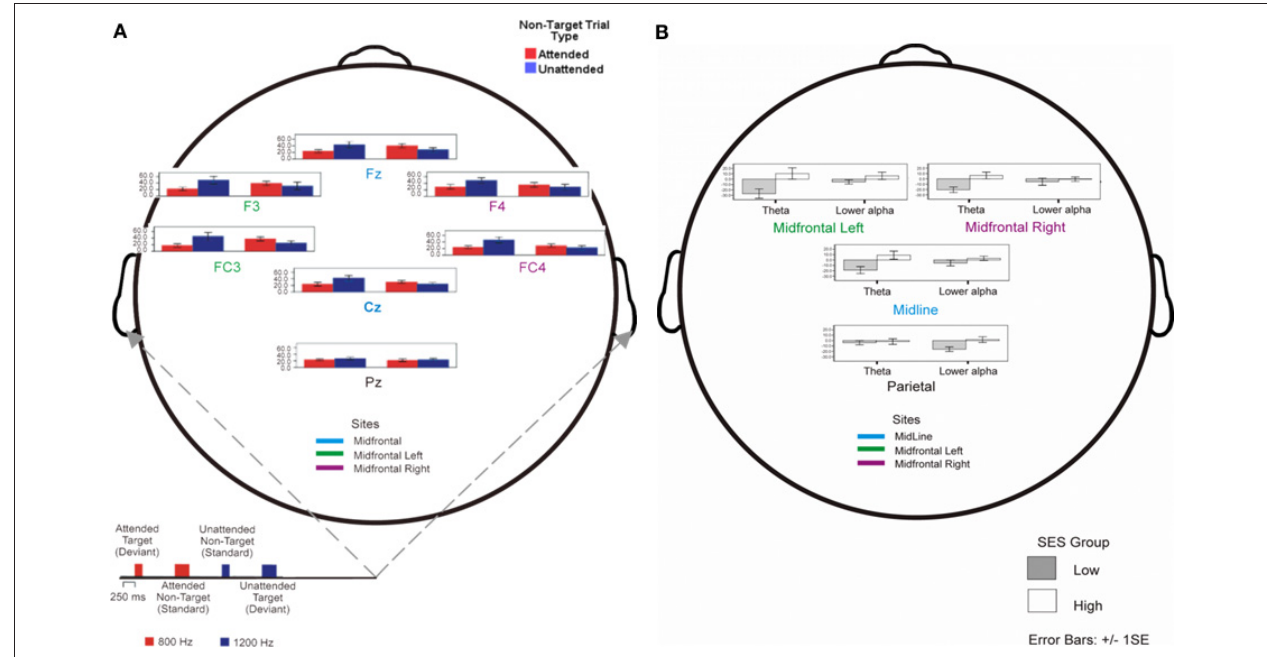
FIGURE 4 | (A) Group-mean event-related theta (3.7–6.4Hz) power of single trial data (non-target tones) averaged with respect to attended (red) and unattended (blue) tones are shown for high and low SES children. (B)